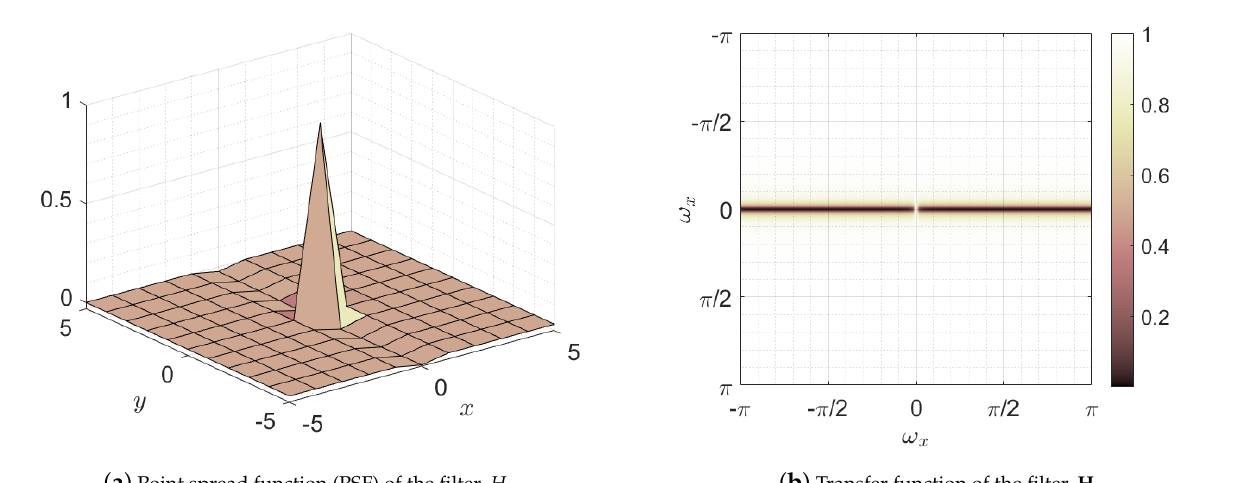
Figure 11. Representation of the filter used in the first stage of blood vessel suppression: ( a ) space domain representation of the filter or point spread function (PSF), and ( b ) frequency domain representation or transfer